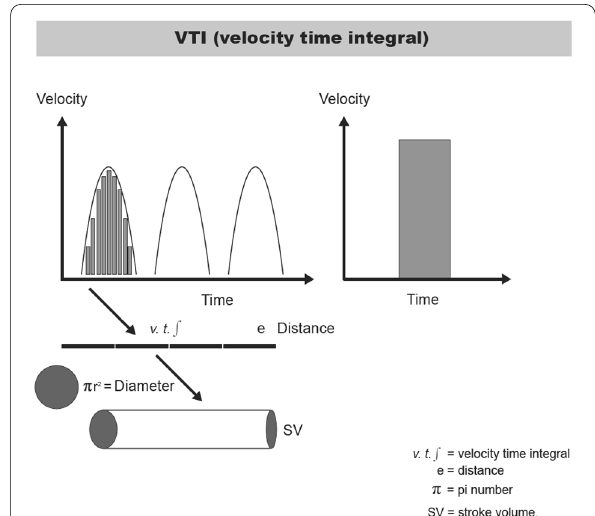
Fig. 2 Mathematical explanation for VTI calculation